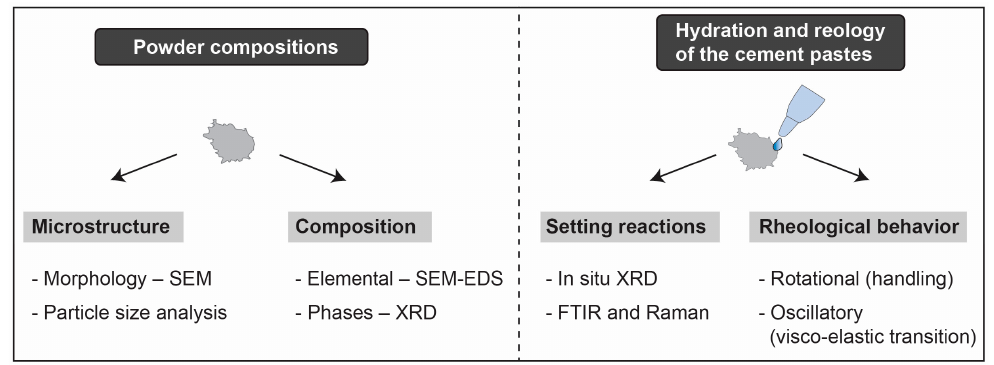
Figure 1. Experimental fl owchart.